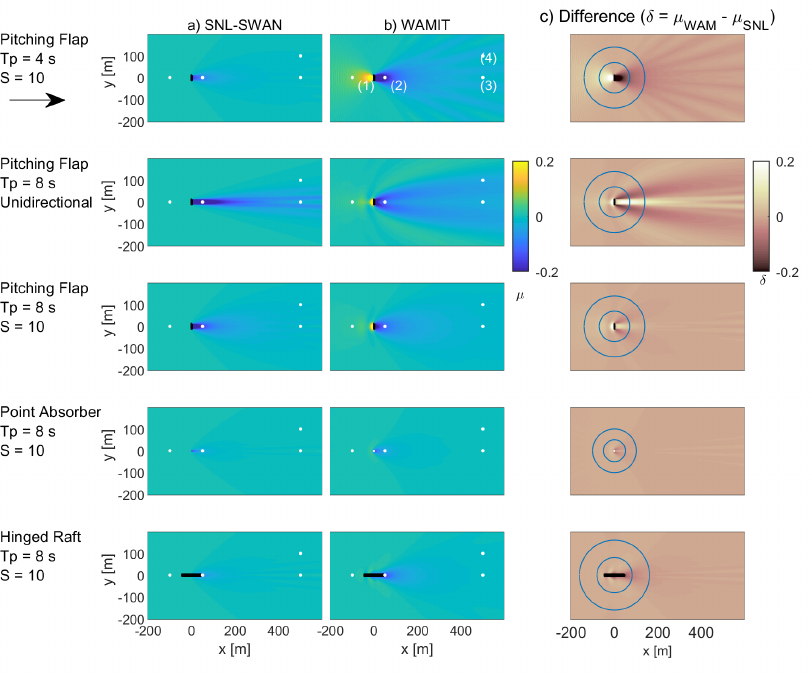
Figure 5. Single WEC Wave Field: ( a ) SNL-SWAN wave field, ( b ) WAMIT wave field, ( c ) difference wave field δ